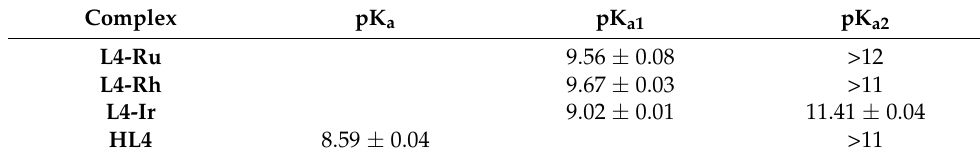
Table 3. pK a values obtained for HL4 and L4-M